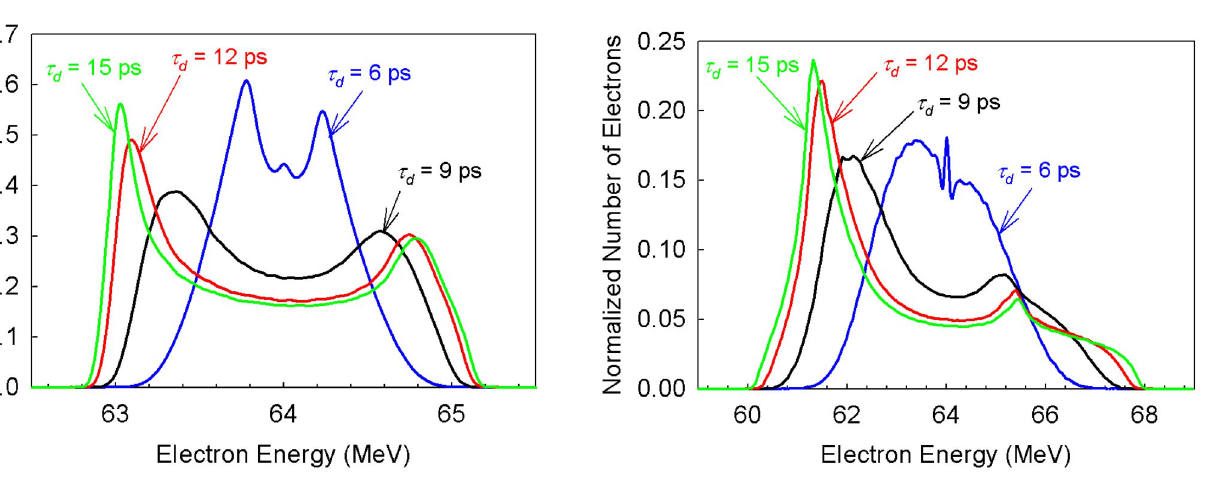
8 : 9 (cid:7) 10 16 cm (cid:2) 3 , the plasma wavelength (cid:2) (cid:1) 2 (cid:4)=(cid:2) (cid:1) 561 cm (cid:2) 1 . Hence, k and k p p sponds to a radial distance of 53 (cid:11) m . Thus, the witness